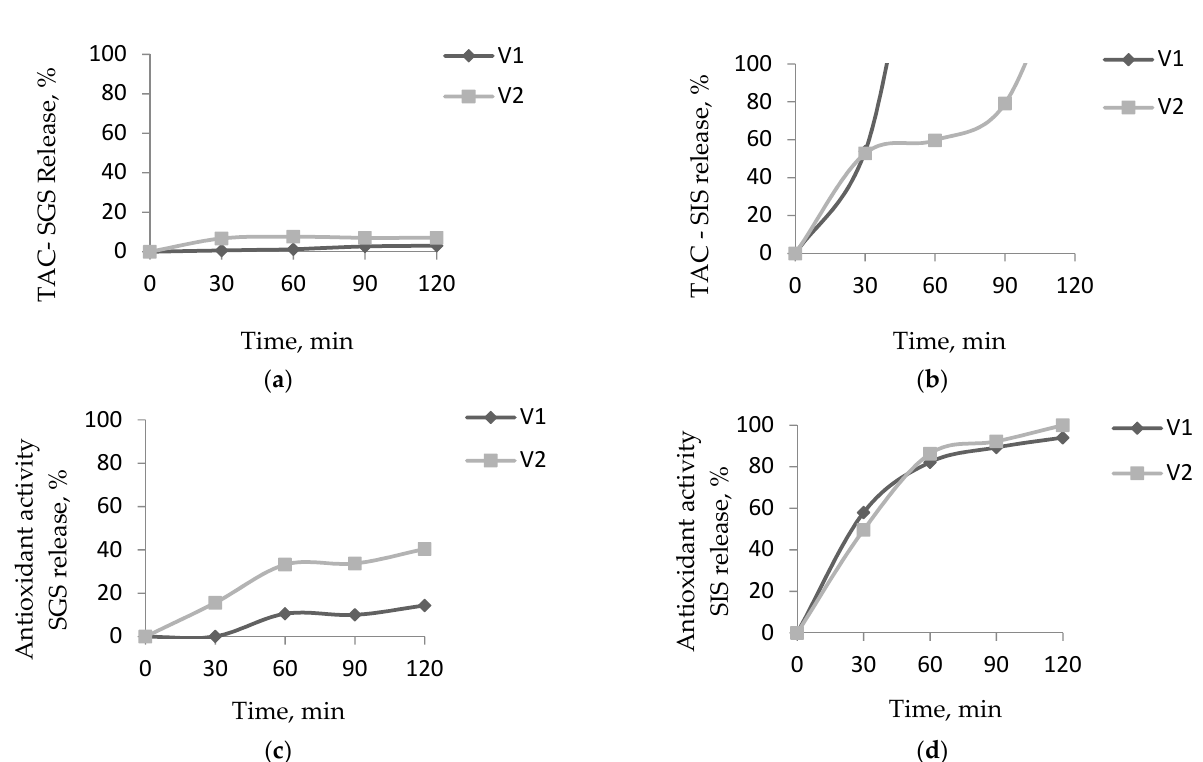
Figure 5. In vitro digestibility of encapsulated anthocyanin and antioxidant activity in simulated gastric fluid ( a,c ) and simulated intestinal fluid ( b,d ).